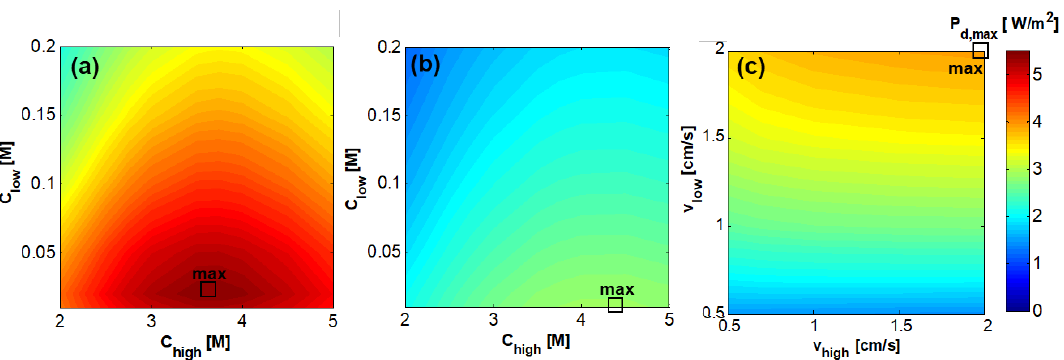
Figure 7. Effect of the feeds inlet concentration on the power density P d , max [W/m 2 ] for the case of RED stack with 50 cell pairs, v L = v H = 1 cm/s, counter-current arrangement, and membrane area of ( a ) 0.1 × 0.1 m 2 and ( b ) 0.1 × 0.88 m 2 ; ( c ) Effect of the feeds inlet velocity for the case of RED stack with 50 cell pairs, C L = 4.5 M and C H = 0.01 M, counter-current arrangement, and membrane area of 0.1 × 0.88 m 2 .